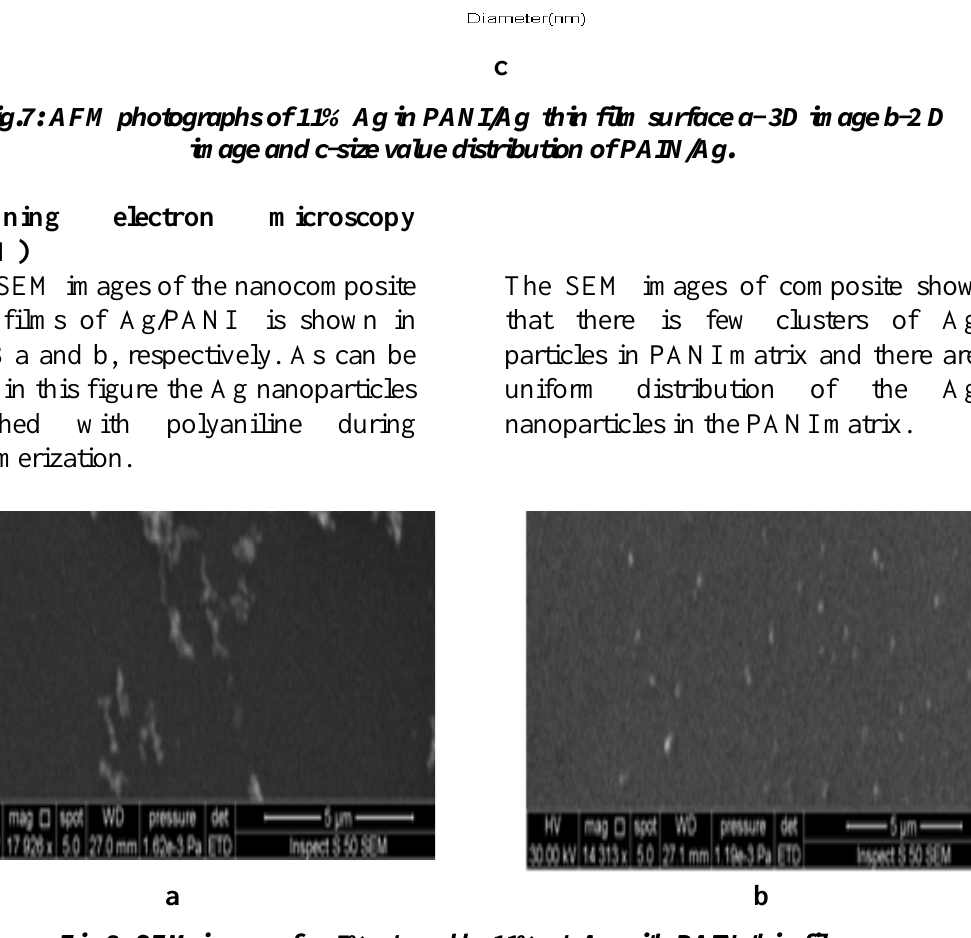
Fig.8: SEM image of a- 5%wt. and b- 11%wt. Ag with PAIN thin